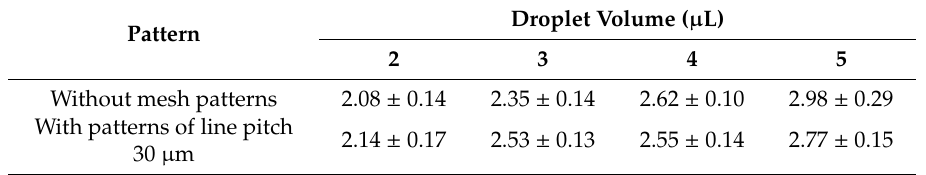
Table 2. Base width of the droplet on XO RGP contact lens with and without mesh patterns (Unit: mm).